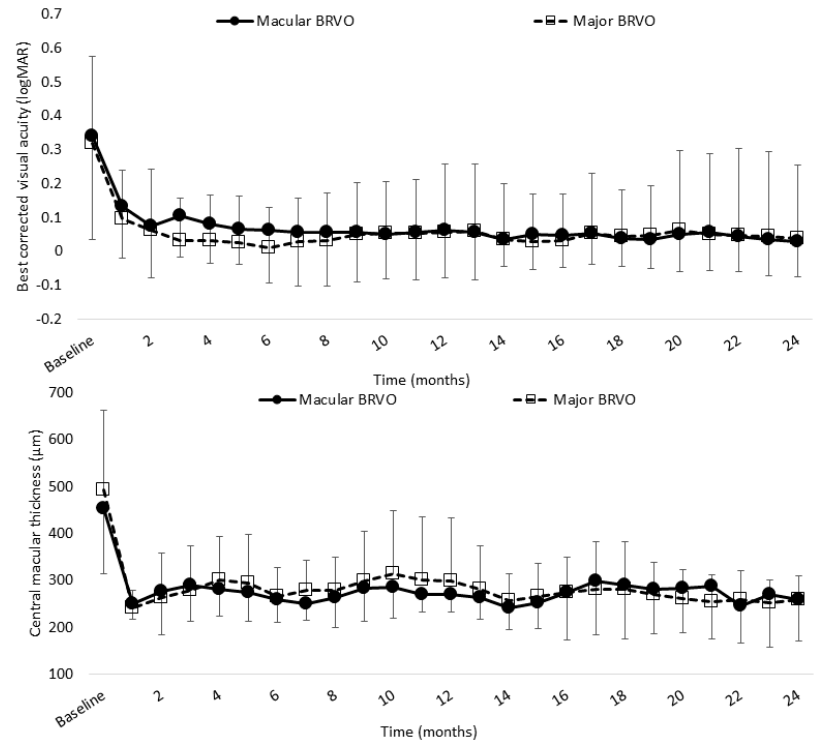
Figure 7. Mean BCVA (logMAR) and CST of major BRVO and macular BRVO over 24 months. Mean BCVA in major and macular BRVO was significantly improved at 12 and 24 months (0.085 (0.20) and 0.061 (0.23), 0.0017 (0.14) and − 0.015 (0.11), respectively) compared with baseline (0.33 (0.26) and 0.30 (0.30), respectively; both p < 0.0001, paired t-test). Mean CST in major and macular BRVO was significantly decreased at 12 and 24 months (299 (135) µm and 257 (52) µm, (270 (129) µm and 259 (70) µm, respectively) compared with baseline (494 (168) µm and 454 (141) µm, respectively; both P < 0.0001, paired t-test). BCVA, best-corrected visual acuity; BRVO, branch retinal vein occlusion; CST, central subfield thickness.